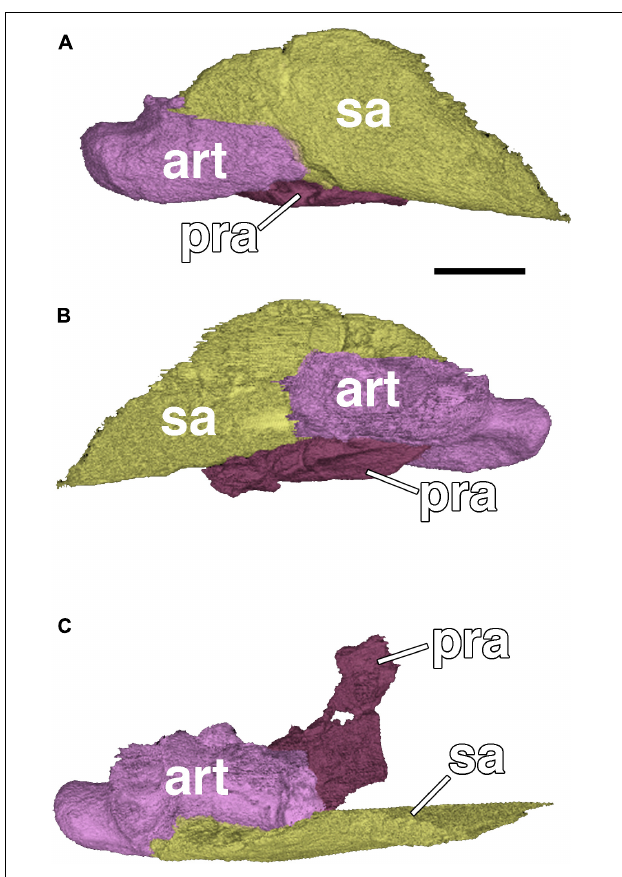
FIGURE 8 | Posterior end of the right mandibular ramus of Nannaroter mckinziei , ROMVP 86541. (A) Lateral view, (B) medial view, and (C) dorsal view. art, articular; pra, prearticular; sa, surangular. Scale bar equals 2 mm.